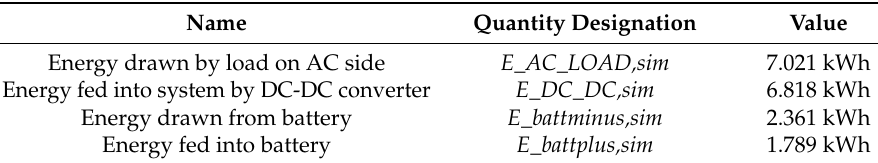
Table 3. Energy comparison during validation—simulation results.